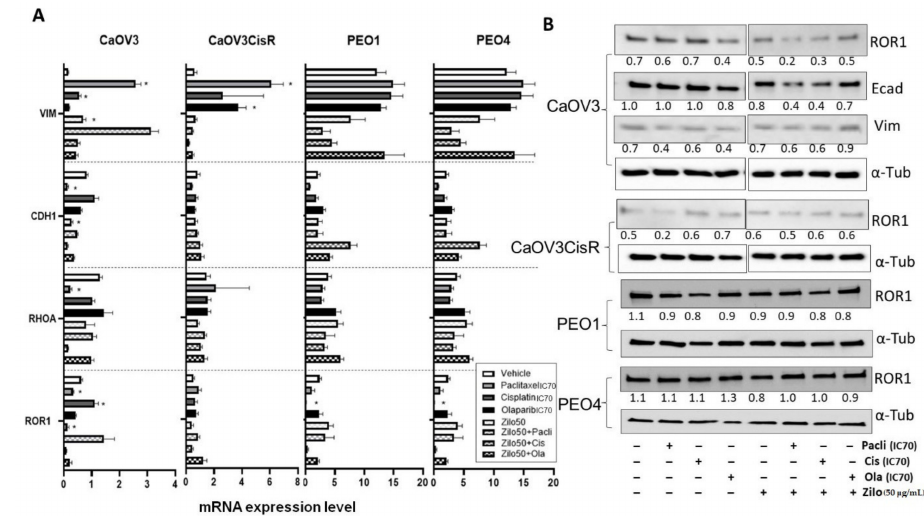
Figure 2. Real-time reverse transcription PCR and Western blot analysis following zilovertamab (“zilo”) +/ − Paclitaxel, Cisplatin, Olaparib treatment in high-grade serous ovarian cancer cell lines CaOV3, CaOV3CisR, PEO1 and PEO4. ( A ). The relative mRNA level of ROR1, CDH1, RHOA and VIM following 72 h treatment. * Significant at p < 0.05 compared with vehicle. ( B ). Protein level of ROR1 following 72 h treatment as measured by Western blot (representative image). The numbers below each lane represent ratios of band intensity of protein versus α -Tubulin, calculated with ImageJ [16].